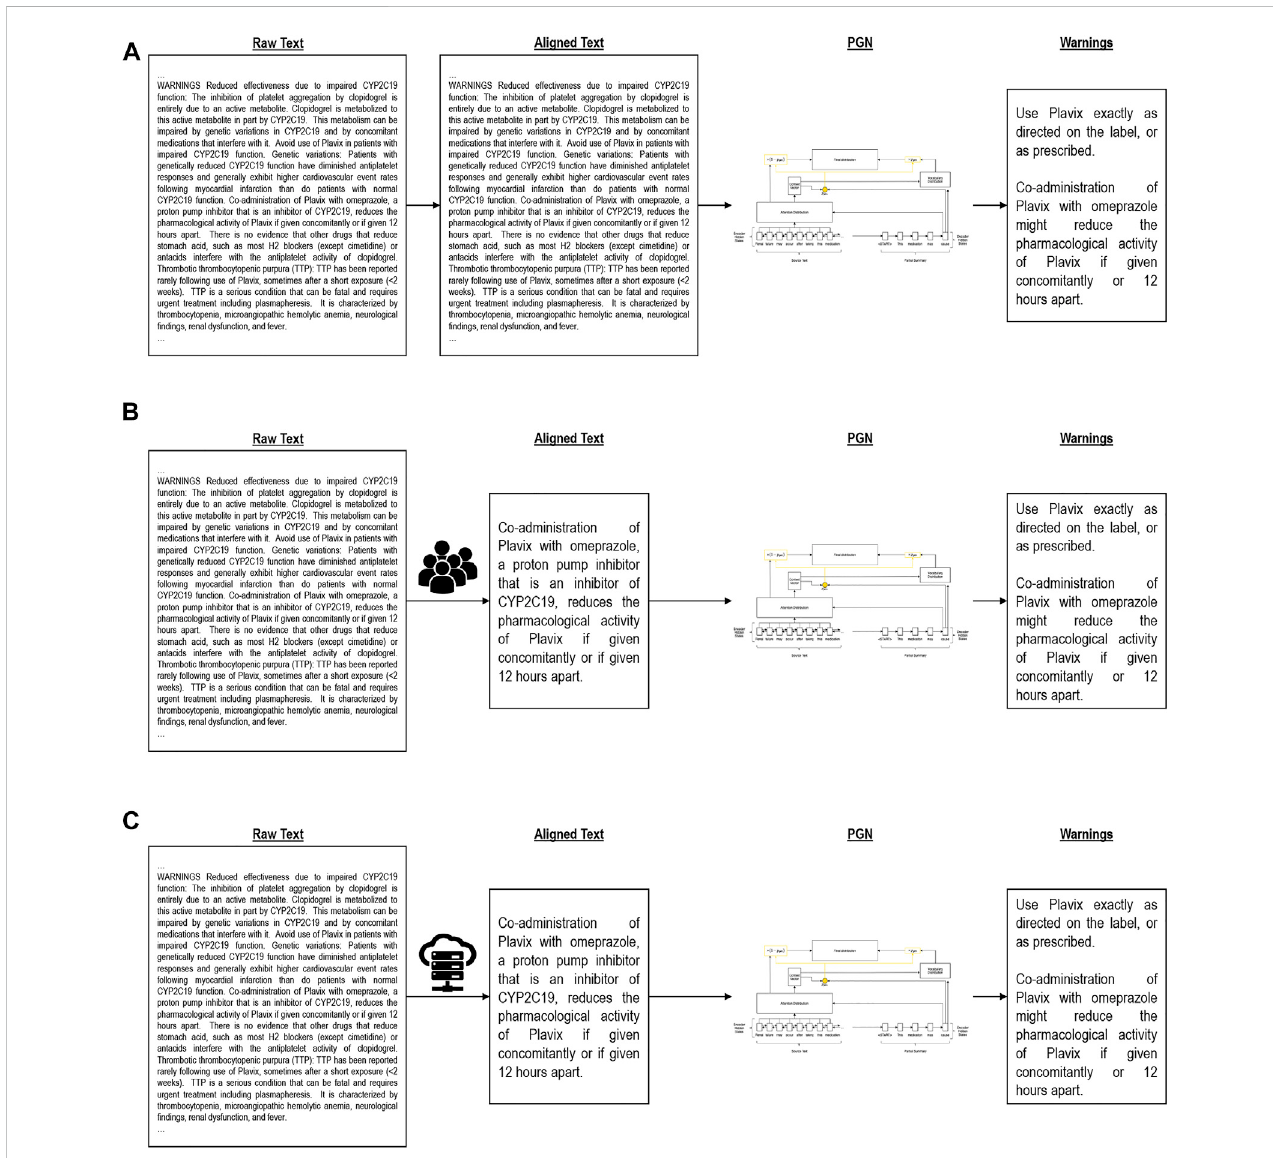
FIGURE 2 Alignment algorithms. (A) is Global alignment, (B) is Manual alignment, (C) is Heuristic alignment.